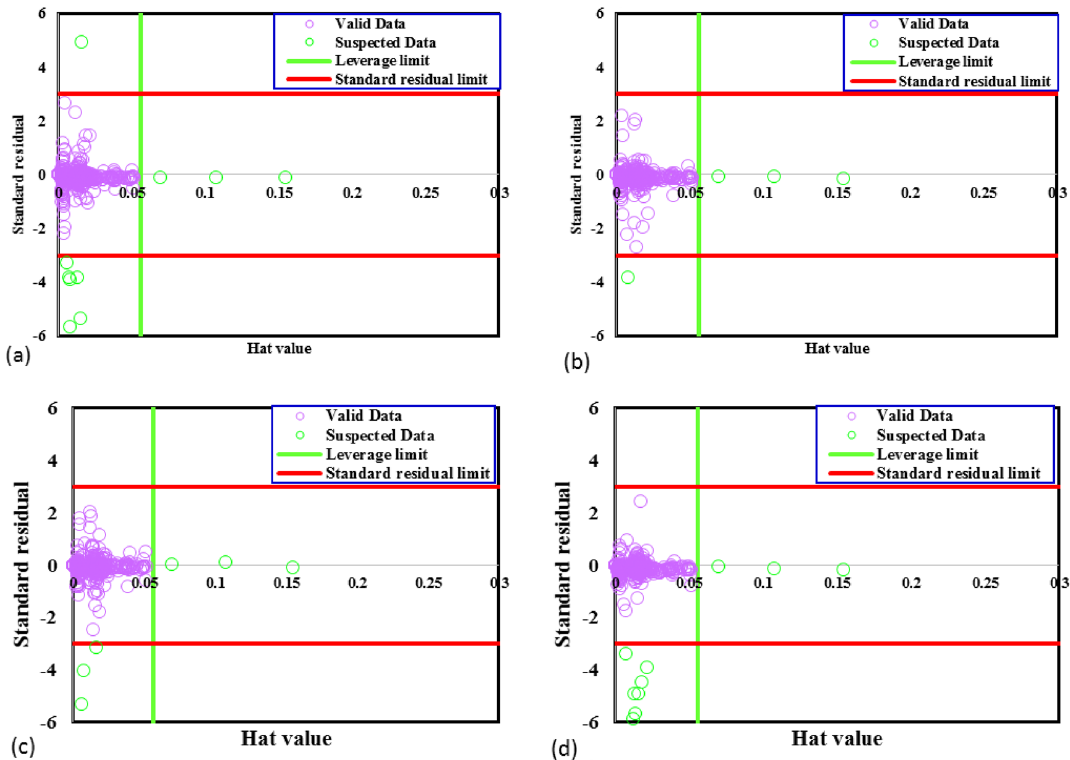
Figure 1. Detection of outliers for GPR model containing kernel function of (a) matern, (b) exponential, (c) squared exponential, (d) rational quadratic.